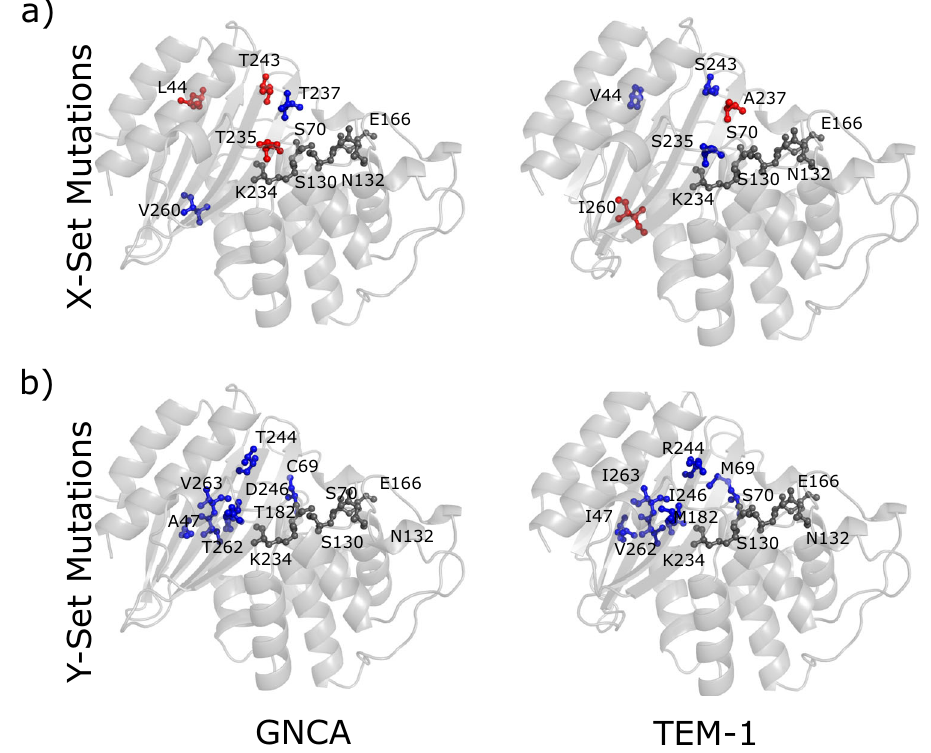
Fig. 2 Residue positions selected for substitution in sets X and Y. a Non-common and sequentially non-conserved residues substituted in set X shown as sticks on the cartoon representation of GNCA and TEM-1 β -lactamase. b Common and sequentially non-conserved residues substituted in set Y shown as sticks on the cartoon representation of GNCA and TEM-1 β -lactamase. The substituting residues are colored based on their DFI pro fi le where blue sticks represent residues with low DFI (hinge) and the red sticks represent residues with high DFI ( fl exible/non-hinge). The catalytic positions are shown in dark